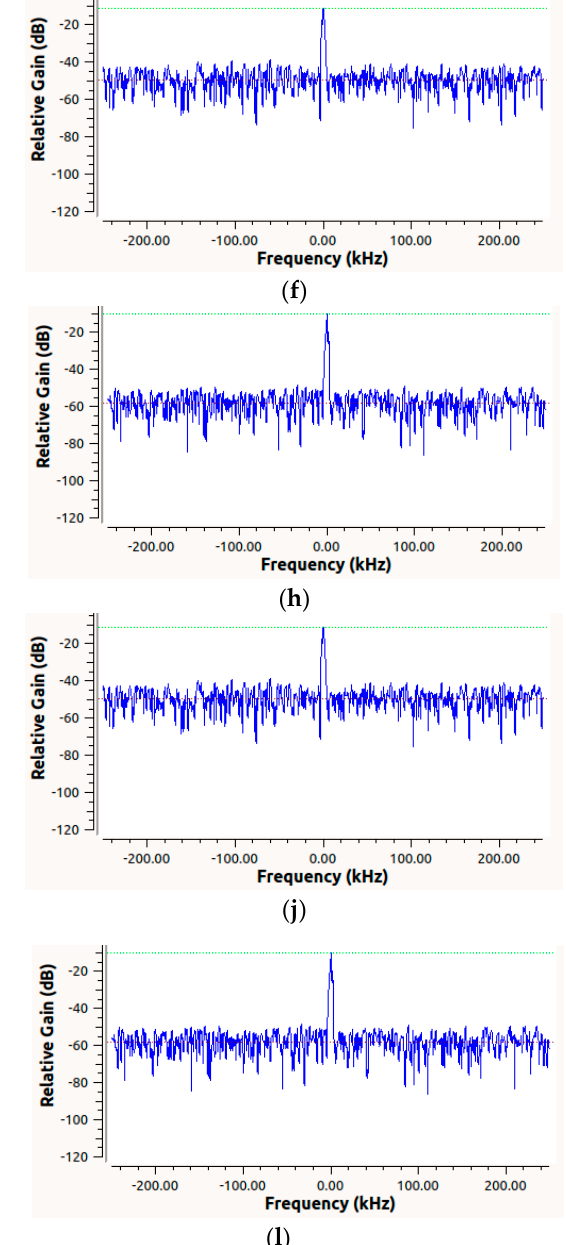
Figure 13. ( a – d ) Comparison of the signals transmitted in the 2400 bps GMSK mode with different SNR values.( a ) SNR = − 3, ( b ) SNR = 5, ( c ) SNR = 9, ( d ) SNR = 14. ( e – h ) Comparison of the signals transmitted in the 4800 bps GMSK mode with different SNR values. ( e ) SNR = − 3, ( f ) SNR = 5, ( g ) SNR = 9, ( h ) SNR = 14. ( i – l ) Comparison of the signals transmitted in the 9600 bps GMSK mode with different SNR values. ( i ) SNR = − 3, ( j ) SNR = 5, ( k ) SNR = 9,( l ) SNR = 14.